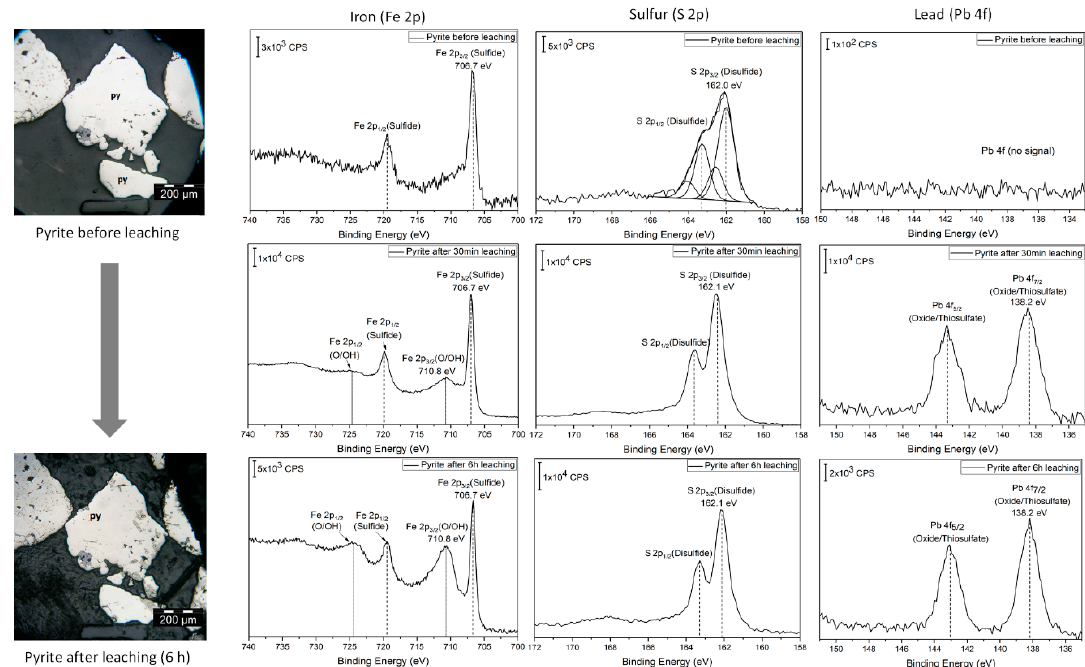
Figure 1. Changes observed during cyanidation of pyrite. The top panels represent the initial results of characterization with polarization microscopy (left) and XPS signals for iron, sulfur and lead (from left to right). The middle panels correspond to XPS signals after the first 30 min of leaching and the bottom panels show the state of the pyrite grain investigated with PM and XPS after six-hour leaching.